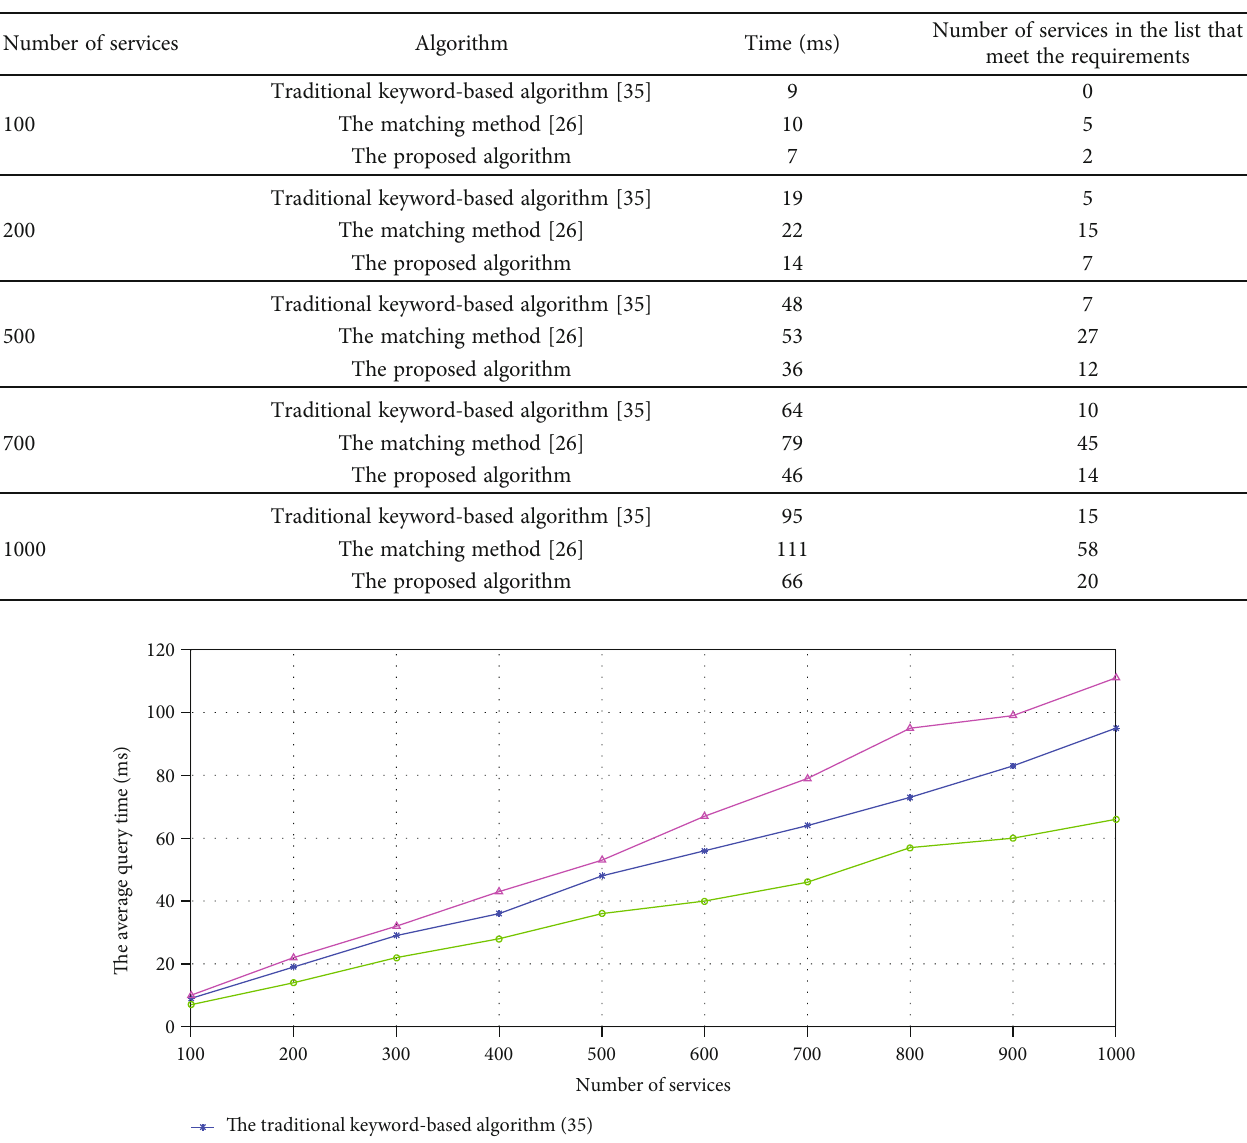
Table 3: Algorithm performance as the number of services increases.